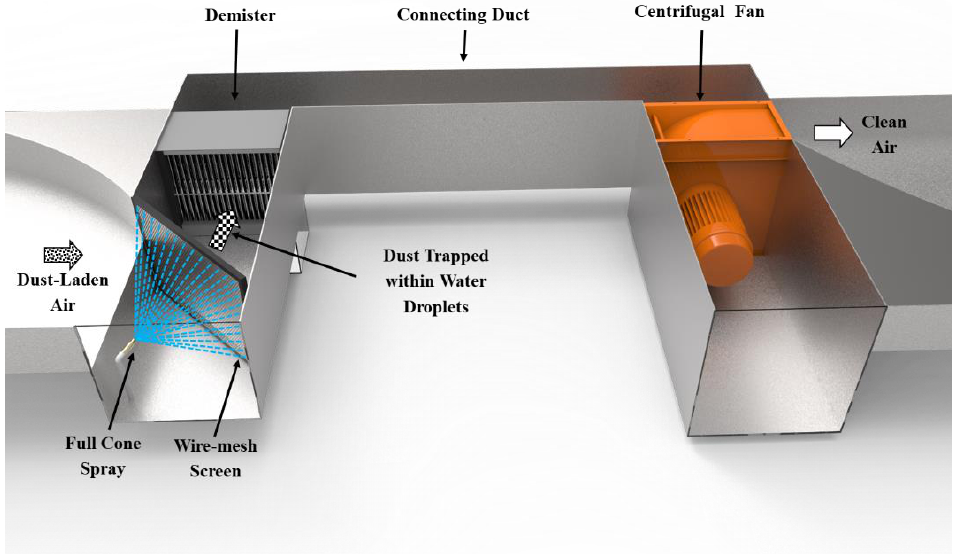
Figure 2. Three-dimensional model of the flooded-bed scrubber integrated into a longwall shearer. The wire-mesh screen is placed vertically at an angle of approximately 45 ◦ to the scrubber inlet. It consists of 20 layers of woven, 88.9 µ m (0.0035 in.), steel mesh screen. A full-cone water spray, placed in front of the screen, delivers 24.6 L/min (6.5 gpm) of water to keep the screen saturated. The 37.3 kW (50-hp) centrifugal fan is rated at 3540 rpm and is capable of drawing 7.0 m 3 /s (15,000 cfm) of airflow at 2.0 kPa (8.0 in.